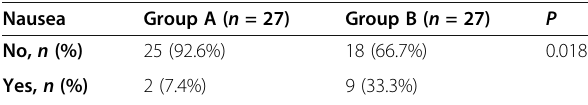
Table 7 Comparison between the two groups regarding nausea during the 48 h from operation Nausea Group A ( n = 27) Group B ( n = 27) P No, n (%) 25 (92.6%) 18 (66.7%) 0.018